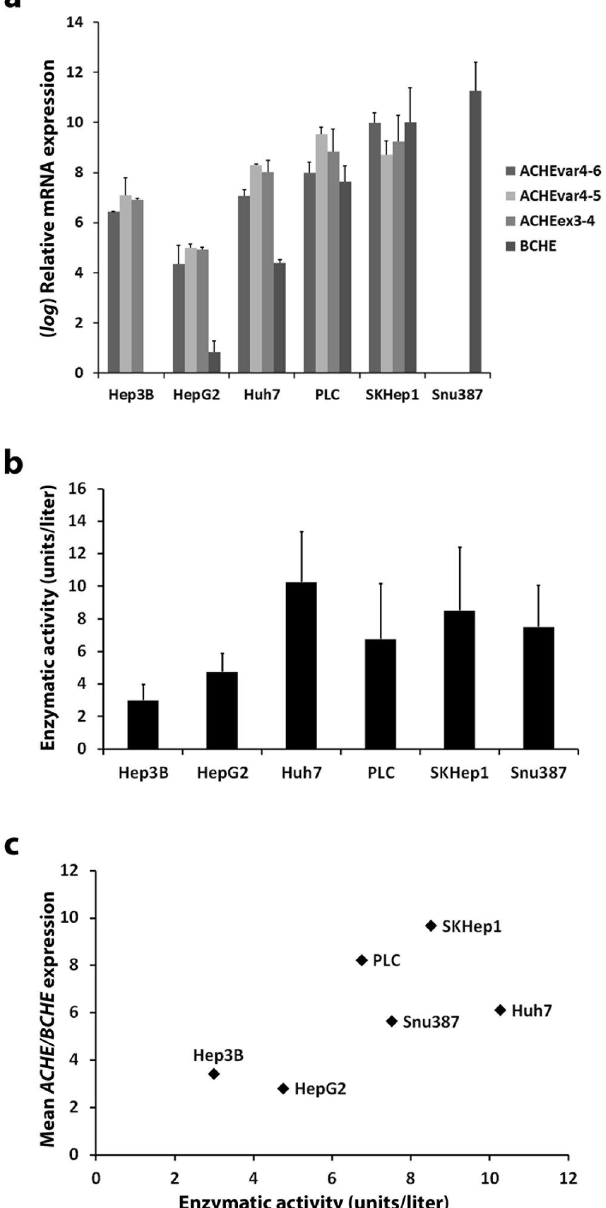
Figure 2. ACHE , BCHE expression and enzymatic activity profiling in selected liver cancer cell lines. ( a ) Human ACHE transcript variants ACHE4-6 , ACHE4-5 expression and another set of primers targeting ACHE exons no. 3 and 4 ( ACHEex3-4 ) present in both variants were used for measuring relative ACHE expression by qPCR in the cell lines. Additionally, BCHE expression was measured by qPCR. Relative quantification was performed with respect to the cell lines with the lowest expression and log fold change represented. TPT1 gene was taken as reference and ∆∆ Ct method formula was used. ( b ) AChE enzymatic activity in HCC cell lines was measured using an Ellman method based commercial kit. ( c ) Mean ACHE / BCHE expression values and enzymatic activities were plotted for observation of correlation. Enzymatic activity numerical values were normalized by division to the highest value. All error bars represent the standard